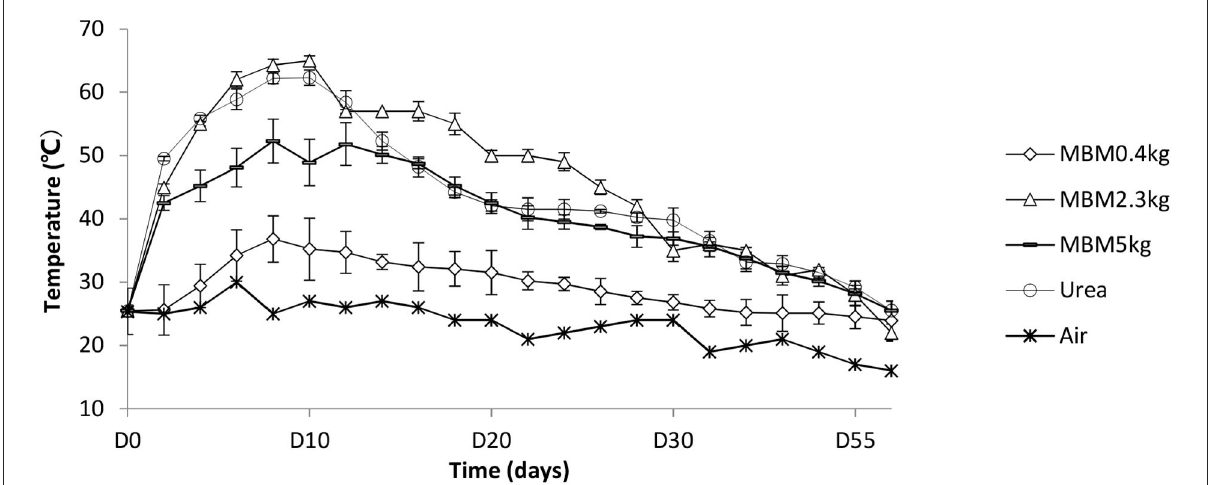
FIGURE1 Temperature dynamics during composting experiment. MBM, asparagus straw with additive meat and bone meal; urea, asparagus straw with additive